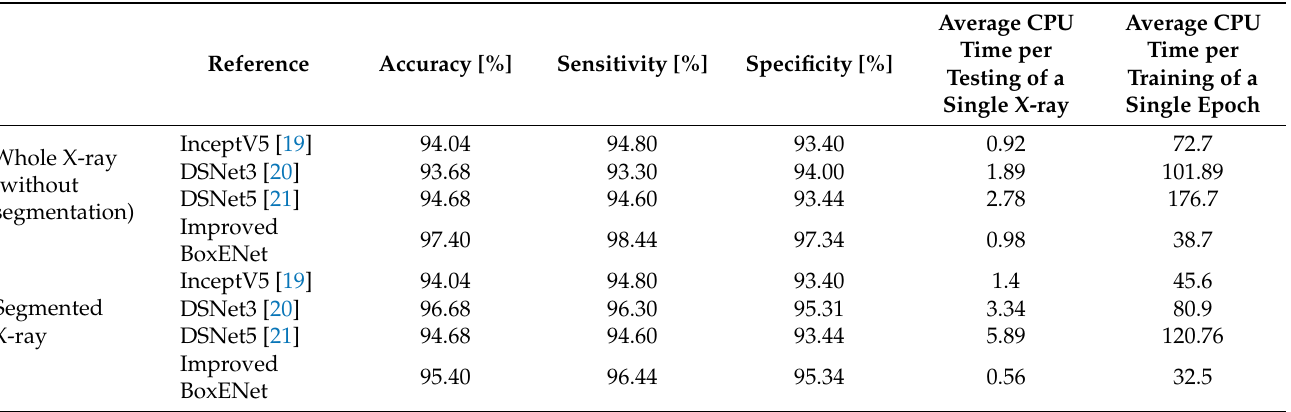
Table 8. Comparison of various CNNs for pneumonia classification with whole and segmented X-rays.